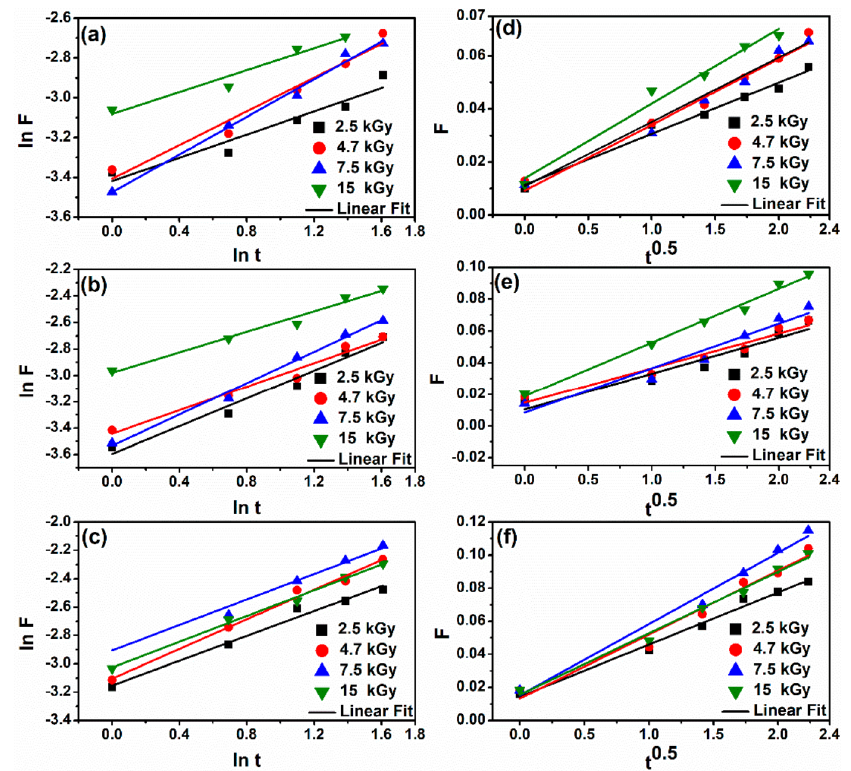
Figure 3. Swelling kinetics curves for the hydrogels: ( a ) XGCMCGO (50:50); ( b ) XGCMCGO (80:20); ( c ) XGCMCGO (70:30). Plots of F versus t0.5 for the hydrogels: ( d ) XGCMCGO (50:50); ( e ) XGCMCGO (80:20); ( f ) XGCMCGO